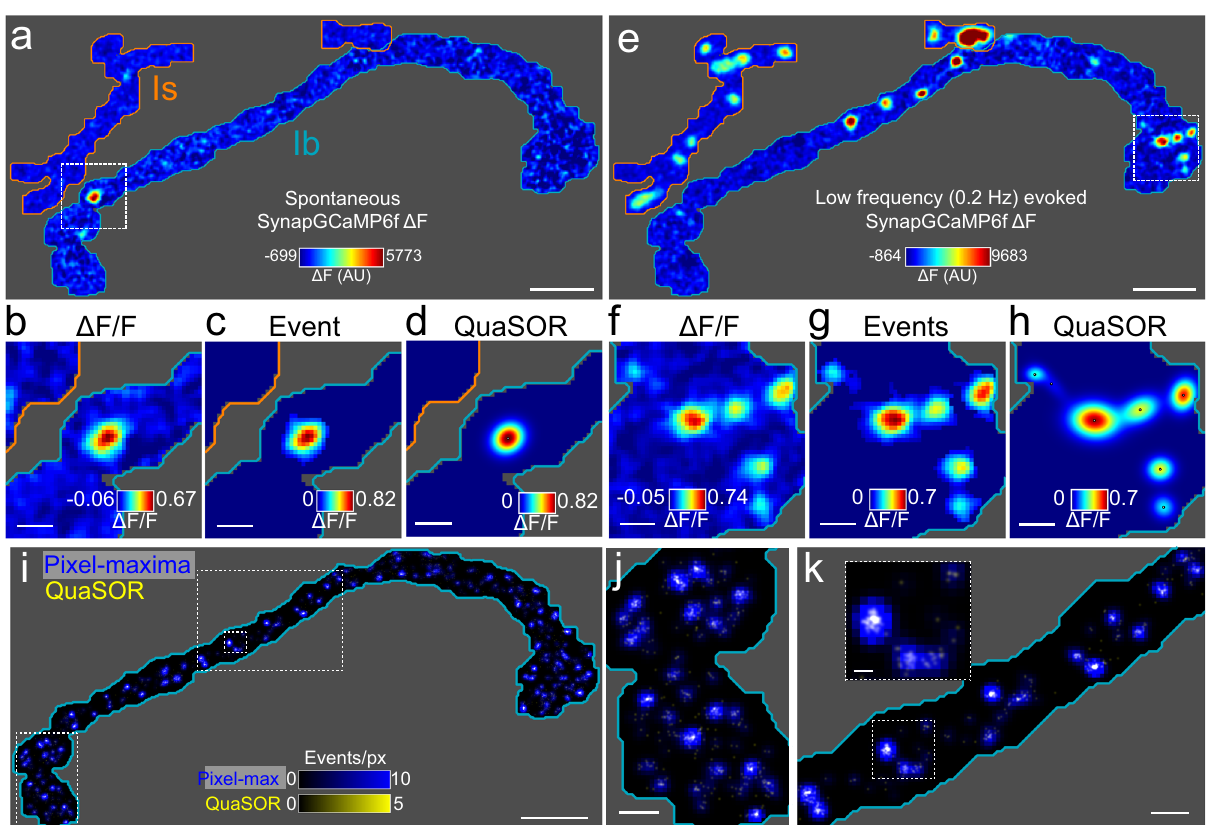
Fig. 1 QuaSOR super-resolution mapping of spontaneous and evoked transmission. a Example spontaneous quantal event showing a full WT NMJ Δ F frame. Gray regions indicate areas of the muscle that were not associated with either Ib or Is NMJ and therefore not analyzed. b Δ F/F corresponding to boxed region in a . c Same event as in a , b showing isolated Δ F/F (only pixels associated with event). d QuaSOR-determined 2D Gaussian model for event in a – c . Black dot indicates maxima coordinate. e Single AP-evoked Δ F response frame. f Δ F/F frame corresponding to boxed region in e . g Same AP-evoked events as in e , f showing isolated Δ F/F. h QuaSOR-determined 2D Gaussian mixture model for 7 events in g . Black dots indicate maxima coordinates for each event component. i – k Comparison of AP-evoked pixel-maxima and QuaSOR mapping methods for the example Ib NMJ in a – g (pixel-maxima method blue, 211.6 nm/px, σ = 211.6 nm; QuaSOR yellow, 21.2 nm/px, σ = 42.3 nm; overlap white). Scale bars: 10 µ m ( a , e , i ), 2 µ m ( b – d , f – h , j , k ), and 500 nm ( k